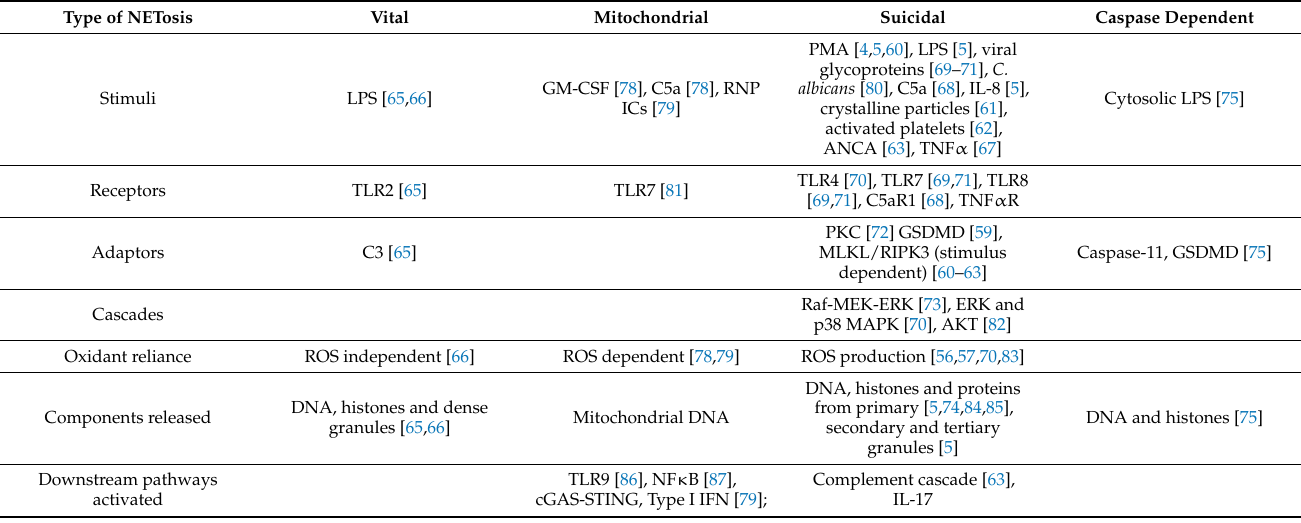
Table 1. Comparisons of NETosis